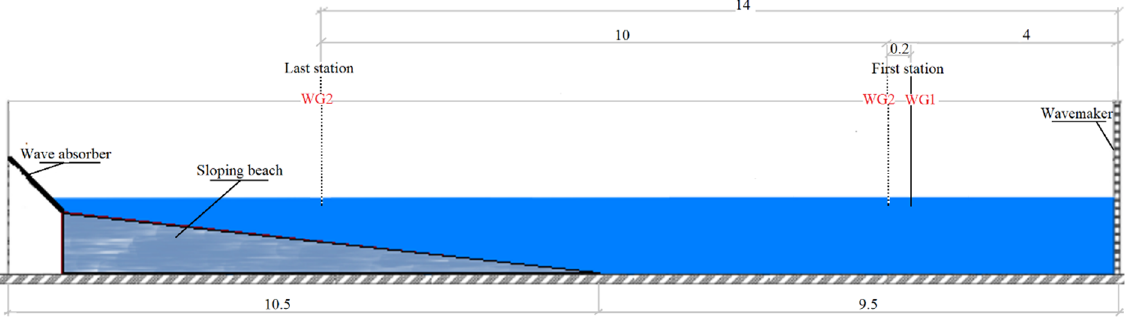
Figure 1. Experimental set ‐ up. WG1 and WG2 are, respectively, wave gauge 1 and wave gauge 2. x = 0 is defined as the mean position of the wavemaker.